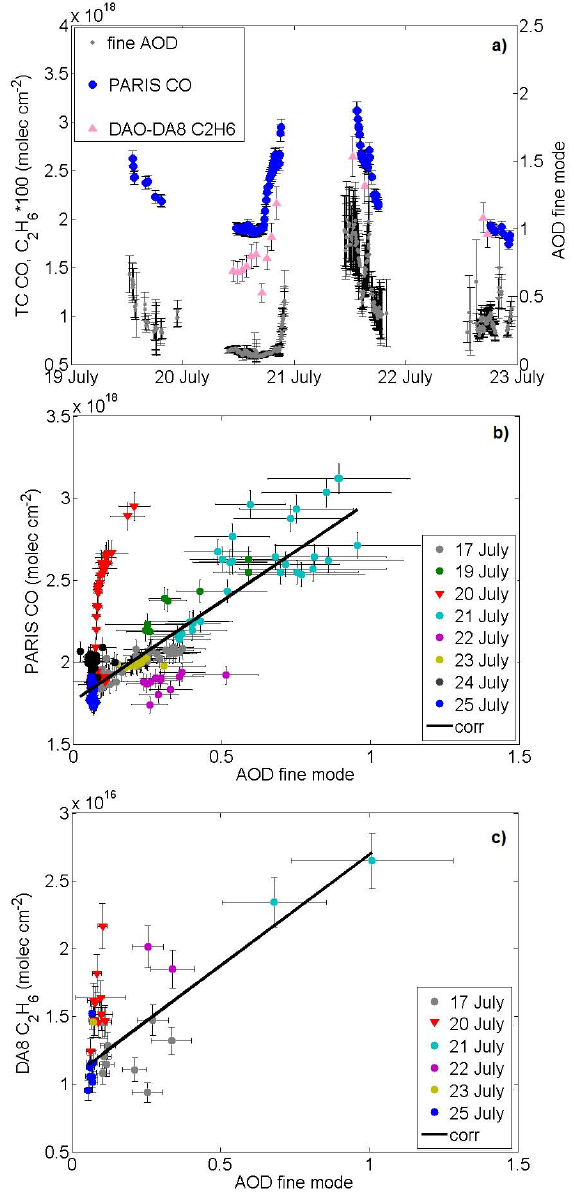
Fig. 7. Panel (a) shows total columns for CO from PARIS-IR (blue circles) and C 2 H 6 from DAO-DA8 (pink triangles) over Halifax be- tween 19 and 22 July 2011 (axis on left). The grey dots correspond to the fine-mode AOD (axis on the right) over Halifax. The labels on the x axis indicate the start of each day at 00:00UTC. Note that the C 2 H 6 columns are scaled by a factor of 100. Panel (b) shows the correlation between PARIS-IR CO total columns and the fine-mode AOD. Panel (c) shows the correlation between DAO-DA8 C 2 H 6 to- tal columns and the fine-mode AOD. In panels (b) and (c) , the thick black line corresponds to the linear regression fit (see Sect. 4.2). Note that for this calculation, measurements on 20 July 2011 (red inverted triangles) are excluded. Black bars indicate the estimated uncertainties, as described in Table 1 and Sect. 2.6.